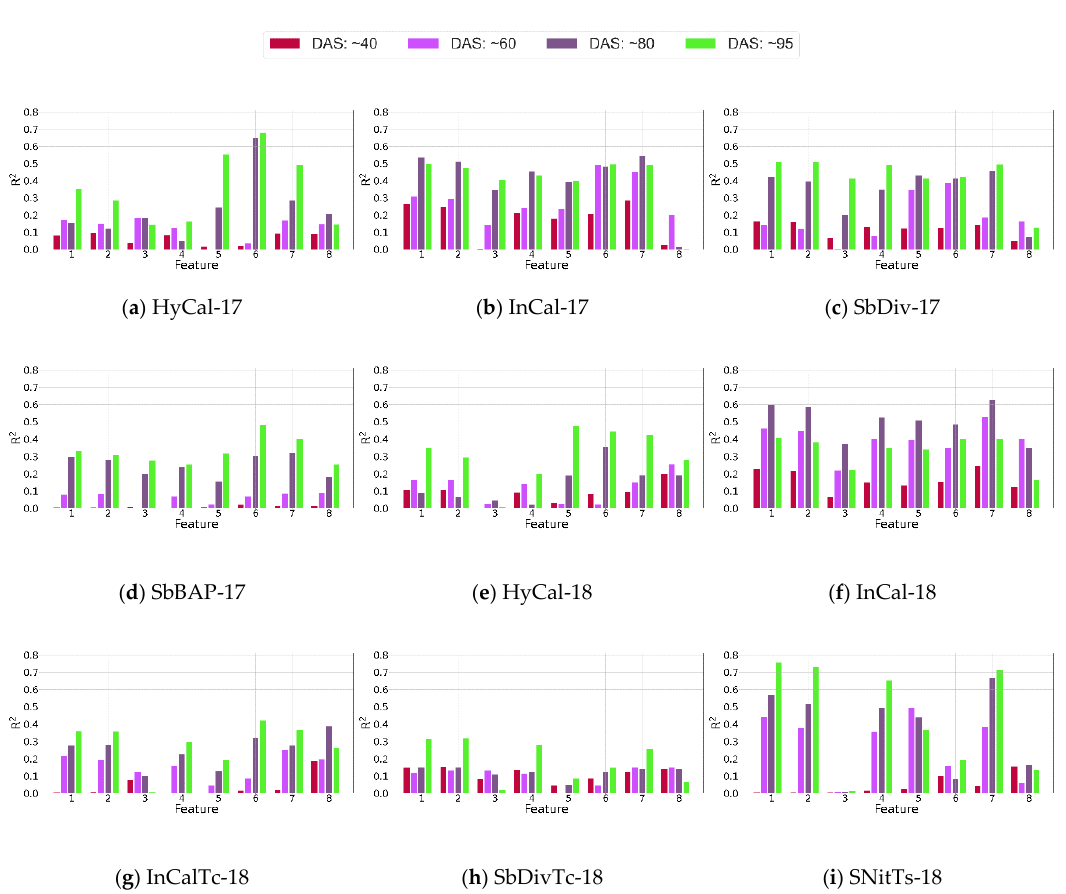
Figure 14. R 2 values of the linear regression-based models developed for the end of season fresh biomass using LiDAR-based features at four stages of growth. Features 1 to 8 represent: #1: 30 th percentile height, #2: 50 th percentile height, #3: 95 th percentile height, #4: coefficient of variation of height, #5: volume, #6: canopy cover (threshold = 0.1), #7: canopy cover (threshold = 0.3), #8: canopy cover (threshold = 0.5).